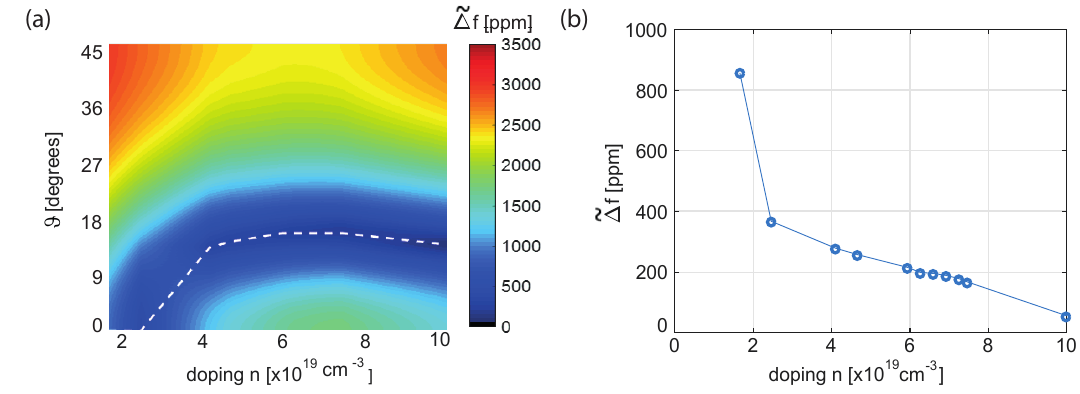
Figure 5. ( a ) ˜ ∆ f for different orientations of the device with respect to the silicon wafer and for different n -dopings of the silicon. The white dotted line represents the minima of the contour plot. ( b ) Minimum temperature variation of the natural frequency of the resonator for different n-dopings of the